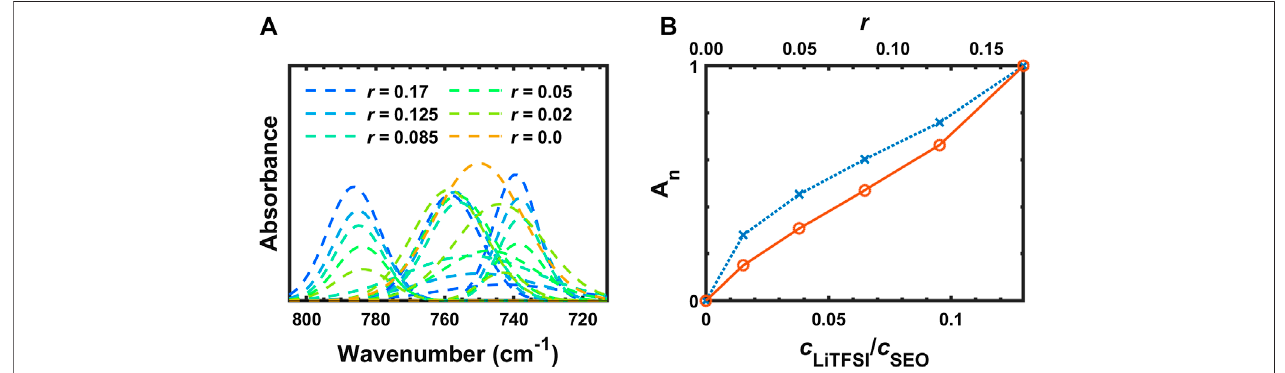
FIGURE 7 | (A) Deconvoluted FTIR-ATR bands from 805 to 713 cm − 1 and (B) concentration dependence of the peak integration of ] CS (787 cm − 1 ) ( ···×··· A n , ─ ○ ─ A c , n ).